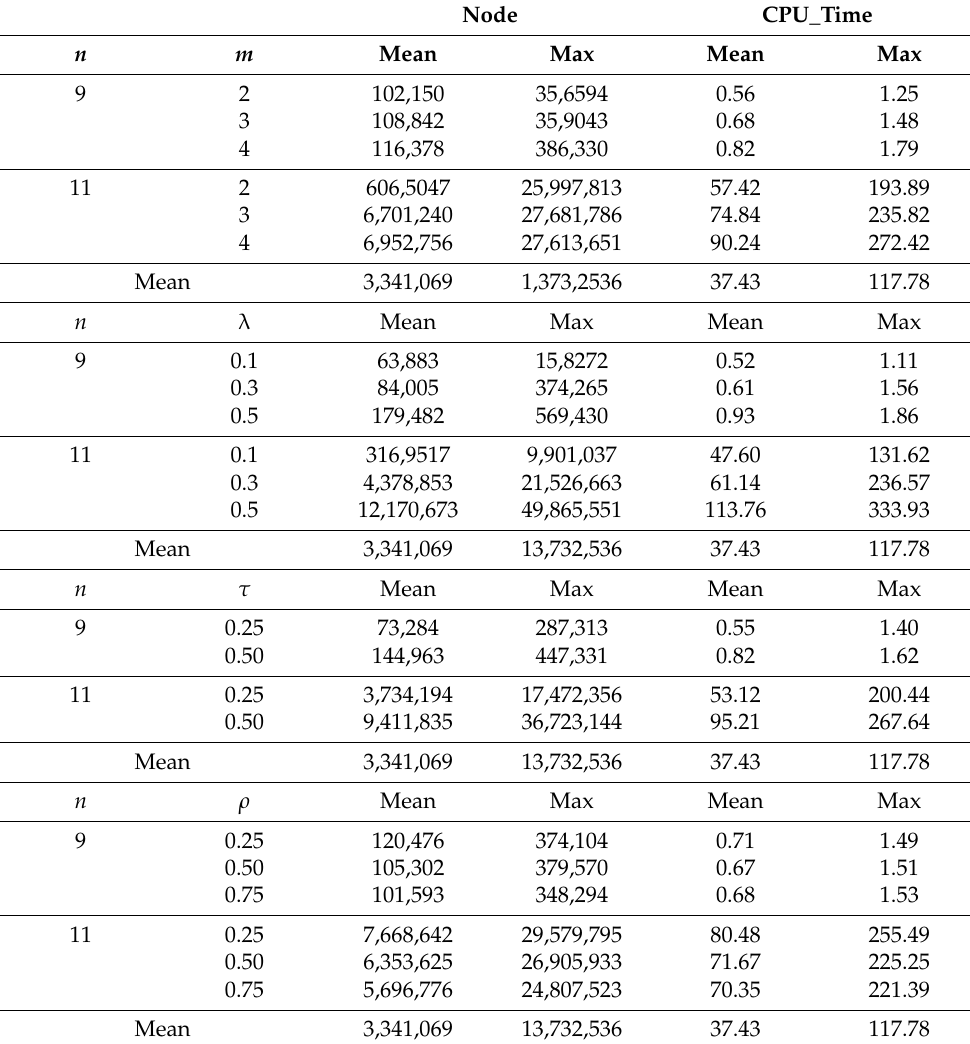
Table 1. Number of B&B nodes and CPU time for small values of n